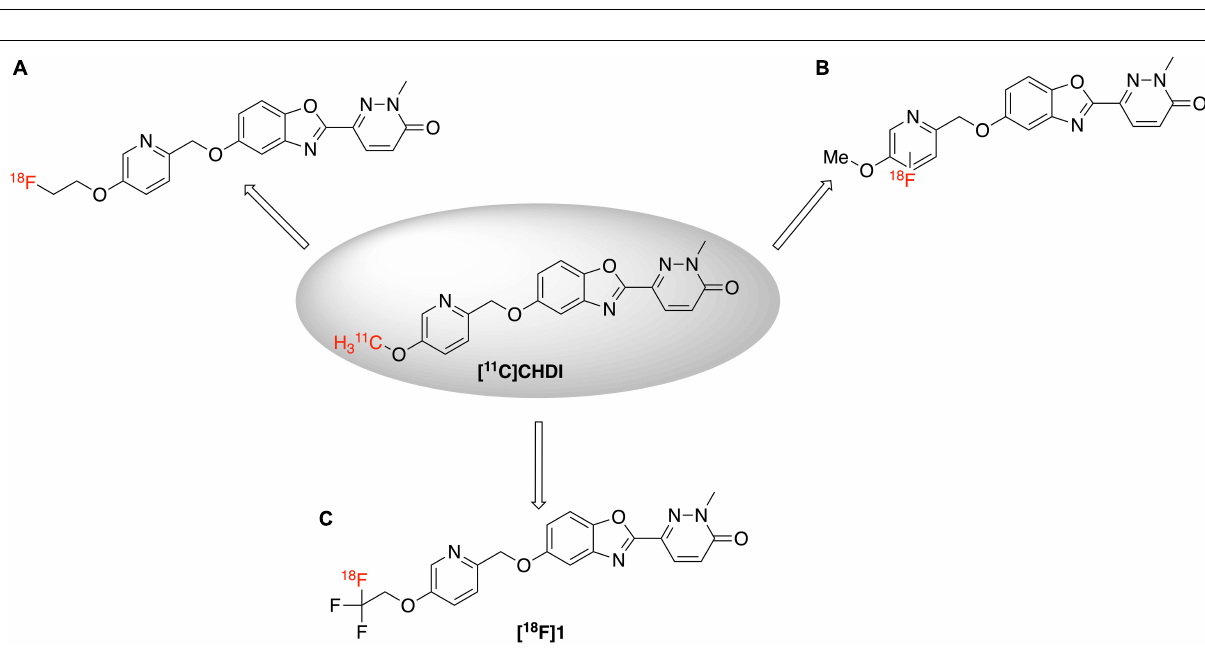
FIGURE 1 | [ 11 C]CHDI and [ 18 F]1 for PET imaging of m HTT.